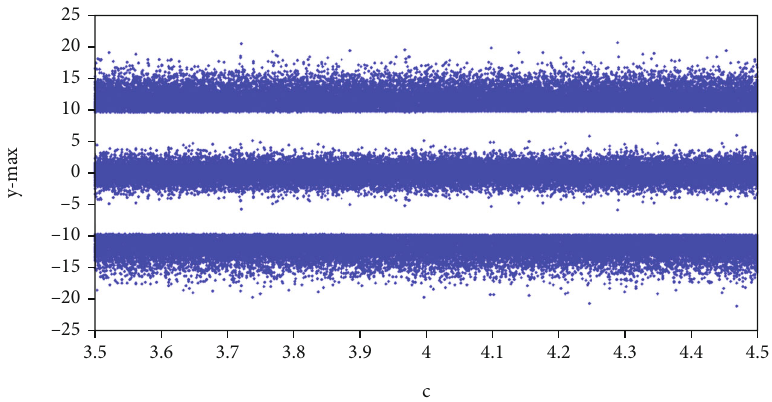
Figure 9: Bifurcation diagram for c ∈ ½ 3 : 5,4 : 5 (cid:2) and η = 0 : 974 .